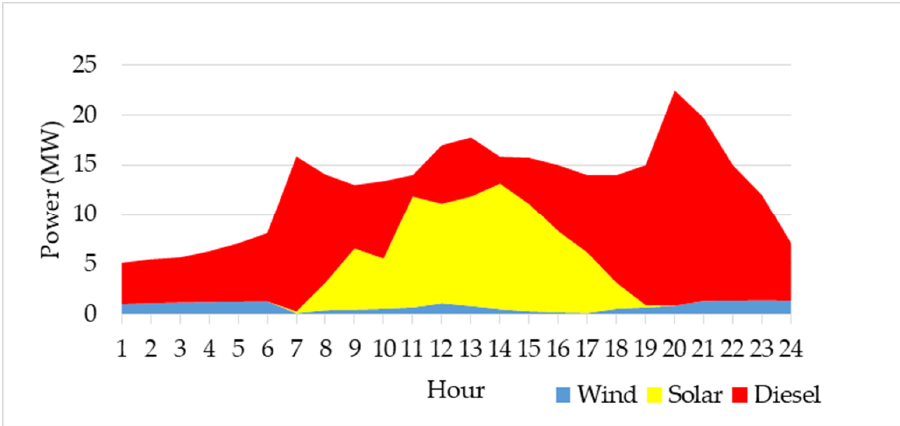
Figure 18. Electricity production for a day (19 April 2030) for the RENES scenario. Source: own elaboration with the model.